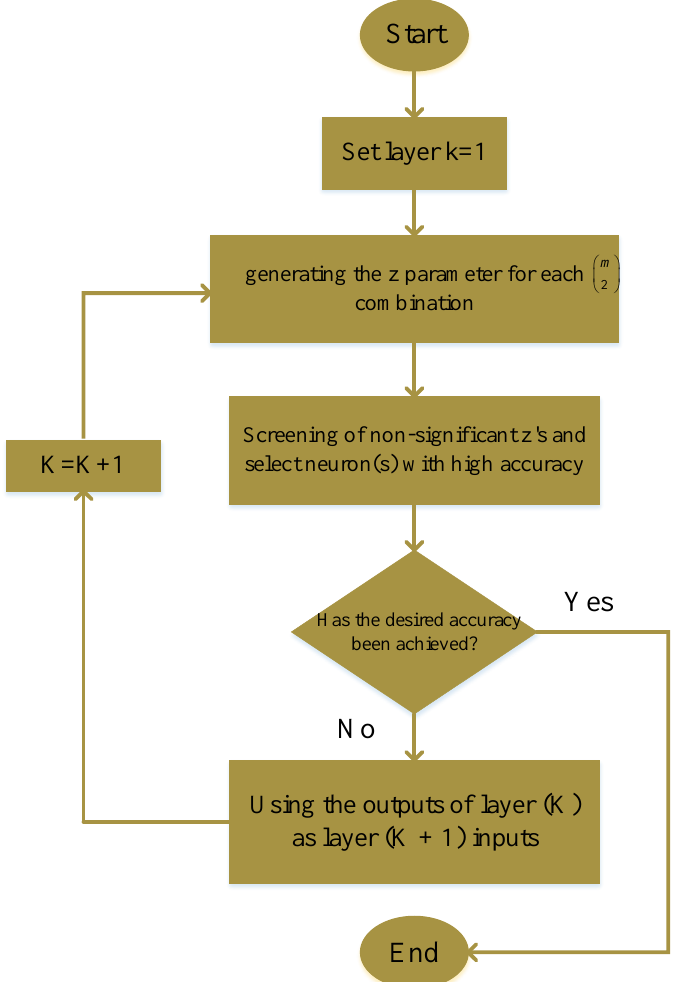
Figure 5. The GMDH neural network training flowchart.